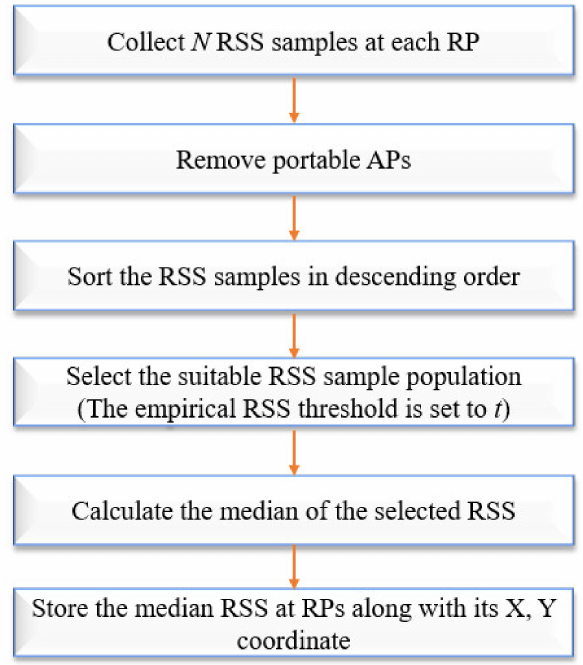
Figure 2. The flow chart of the